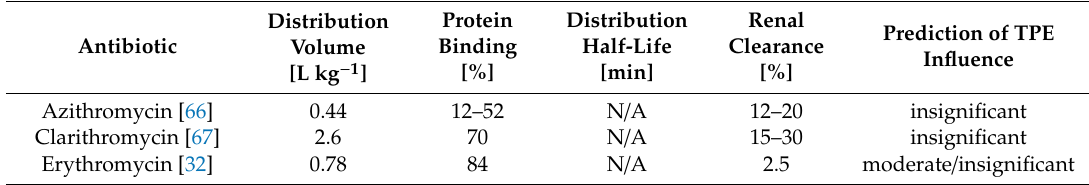
Table 5. TPE and